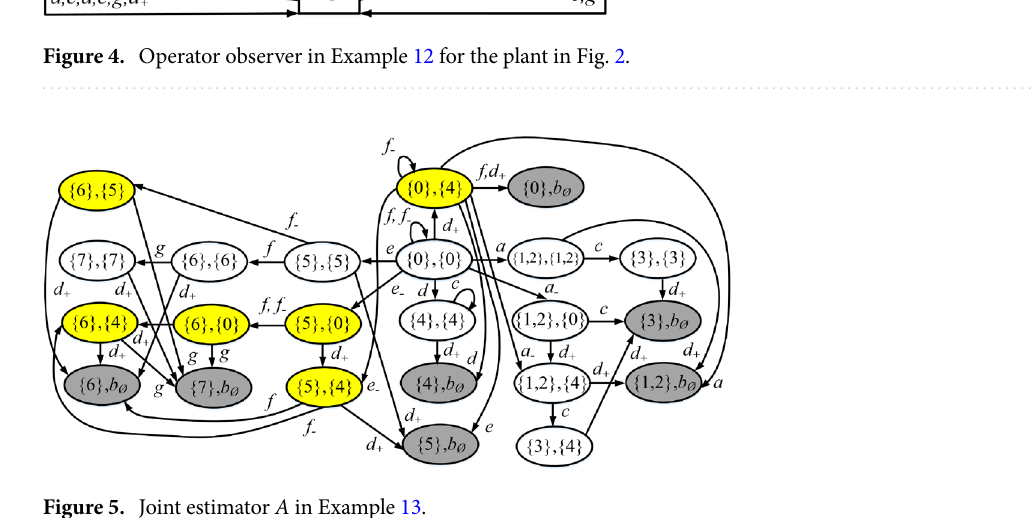
Figure 5. Joint estimator A in Example